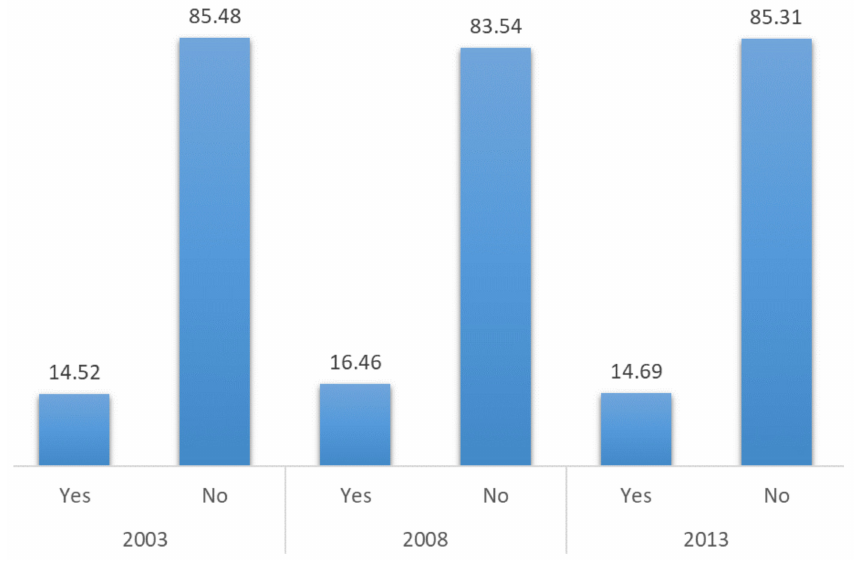
Figure 4. Percentage of women reporting circumcision as a religious requirement.